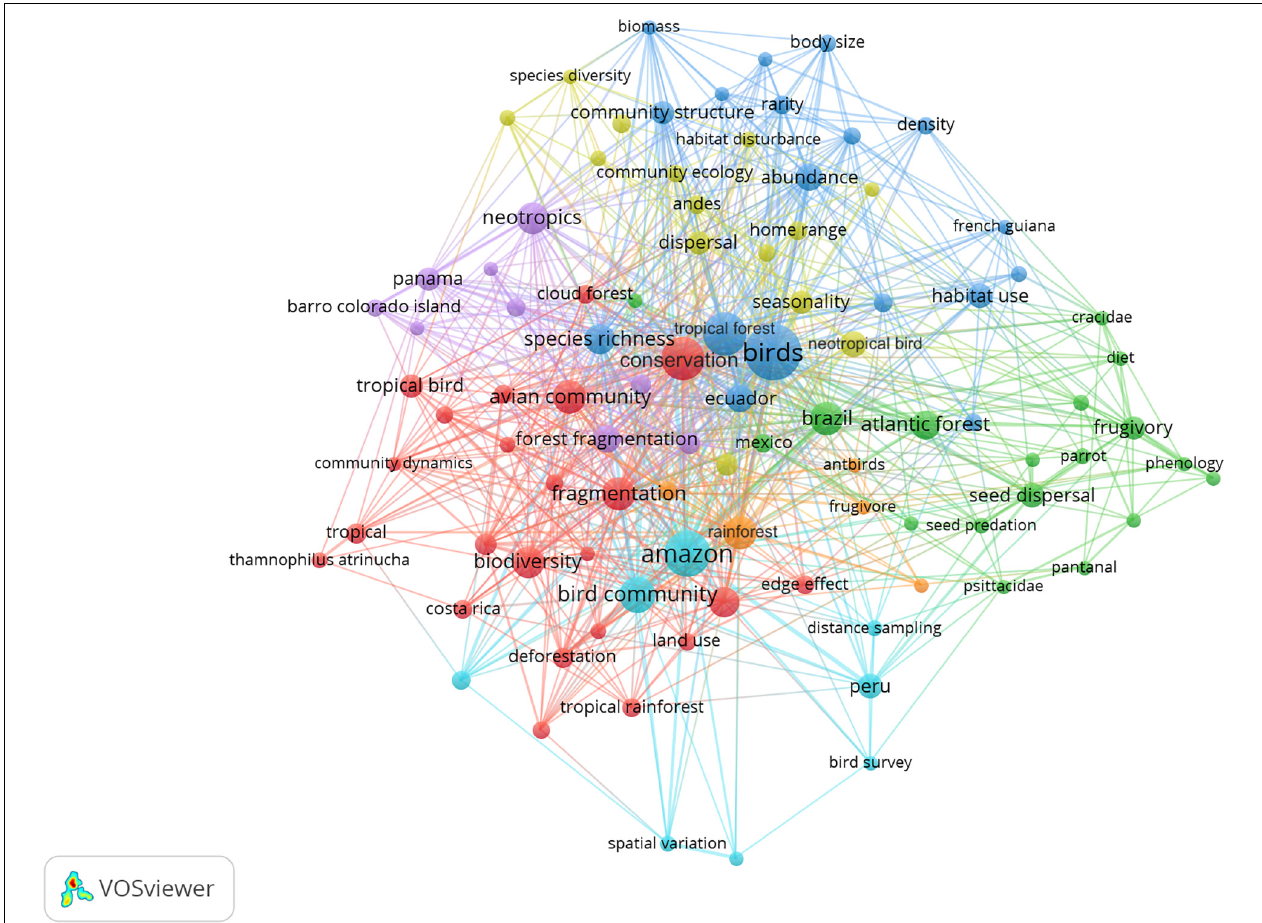
FIGURE 3 | Network analysis of the influence of the big bird plot papers on the scientific literature. Keywords occurring five or more times in citing literature are included. Colors indicate major associations of co-occurring keywords.